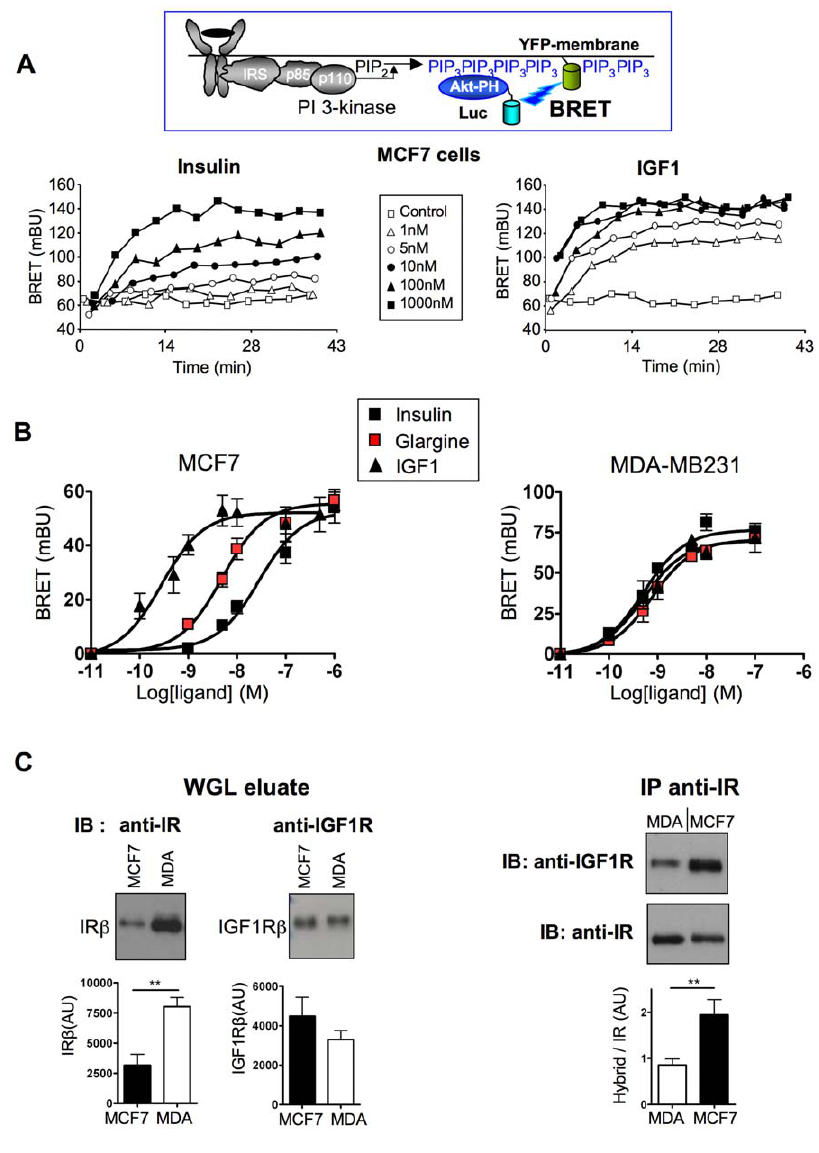
Figure 2. Effect of insulin, glargine and IGF1 on PIP 3 production in intact living cells. Activation of tyrosine kinase receptors by their ligands stimulates the activity of PI-3 kinase, leading to increased phosphorylation of phosphatidyl-inositol 2 phosphate (PIP 2 ) into phosphatidyl-inositol 3 phosphate (PIP 3 ) and subsequent recruitment of Akt to the plasma membrane through its pleckstrin homology (PH) domain. To monitor the production of PIP 3 induced by receptor activation, cells were co-transfected with cDNAs coding for the PH domain of Akt fused to luciferase (Luc-Akt-PH) and YFP fused to the membrane localization sequence of neuromodulin. Cells were pre-incubated for 10 min with coelenterazine and then stimulated with increasing ligand concentrations. (A) Typical experiment showing real-time insulin or IGF1 effects on PIP 3 production in MCF-7 cells. (B) Dose-dependent effect of insulin, glargine and IGF1 on PIP 3 production in MCF-7 and MDA-MB231 cells. Ligand-induced BRET (BRET above basal at the plateau) was determined for each ligand concentration and was used to establish dose- response curves. Results are the means 6 S.E.M. of 5 to 6 independent experiments. EC50 for insulin, IGF1, glargine and other insulin analogues are given in Table 2. (C) Left panel: Receptors were partially purified from MDA-MB231 and MCF-7 cells by WGL chromatography. WGL eluates (12 m g of protein) were submitted to electrophoresis and western-blotting. IR and IGF1R expression levels were evaluated by immunoblotting (IB) using anti-IR (C-19) and anti-IGF1R (C-20) antibodies. Right panel: After normalization of the eluates for IR content, immunoprecipitation (IP) was performed using anti-IR antibody (CT1) and hybrid receptors were detected using anti-IGF1R antibody. Blots were then stripped and reprobed with anti-IR antibody. Results are representative of 6 immunoprecipitation experiments performed on three independent batches of receptor preparations (**, p , 0.01).